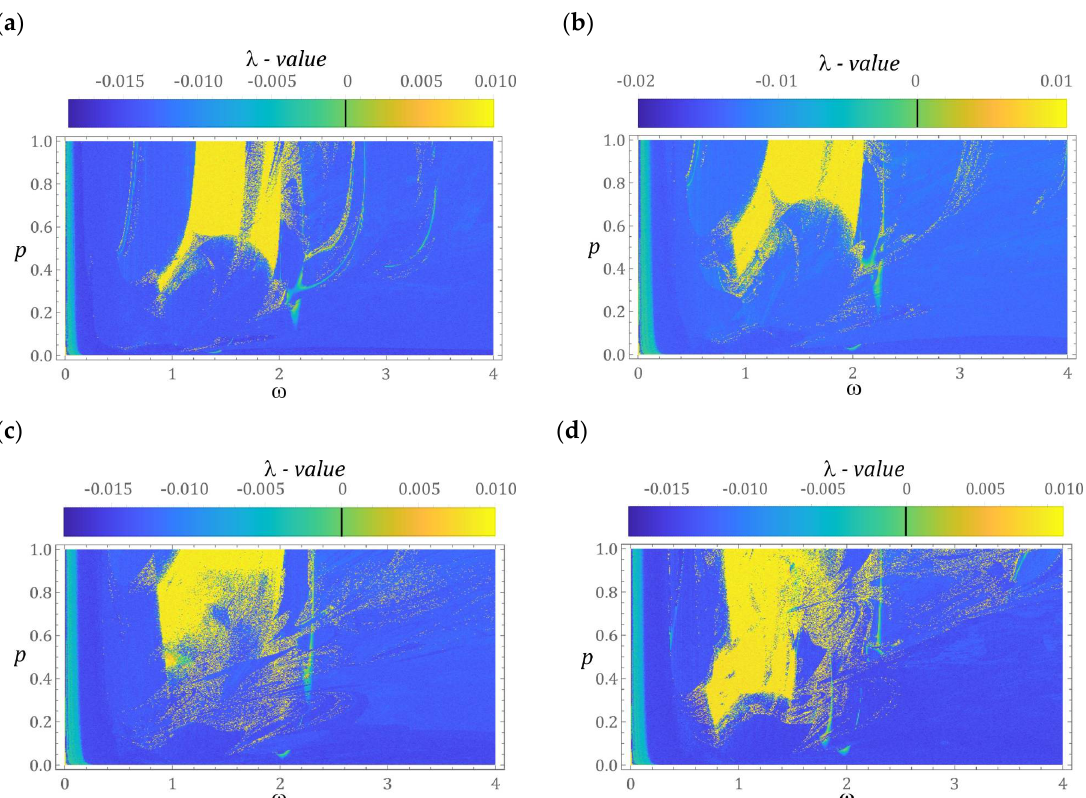
Figure 4. Influence of β on the distribution of the largest Lyapunov exponent, λ , for various geomet- rical factors, β : ( a ) β = 1, ( b ) β = 2, ( c ) β = 3, and ( d ) β = 4 .